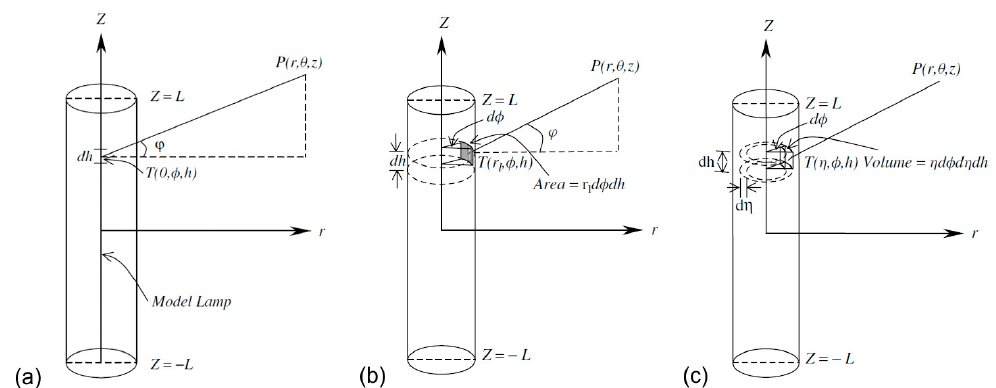
Figure 4. Lamp emission models: ( a ) line source model; ( b ) surface source model; ( c ) volume source model. Reprinted with